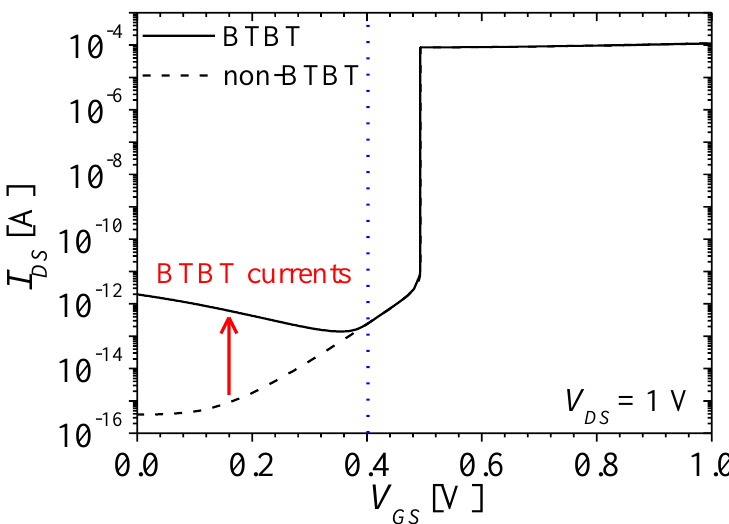
Figure 4. Comparison of I DS - V GS characteristics of NFBFET between considering and ignoring the BTBT at V DS = 1 V.